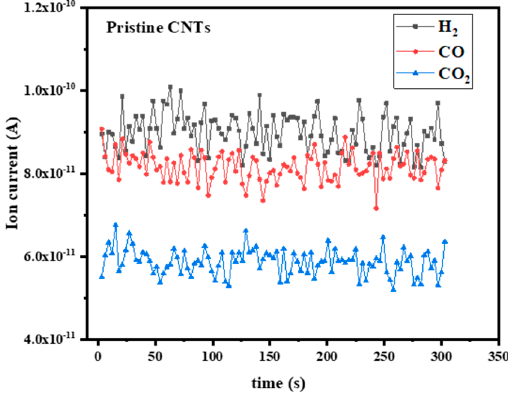
Figure 9. Background residual gas in UHV at room temperature for pristine CNTs without FE operation, corresponding to a total pressure of 1 × 10 –6 Pa.